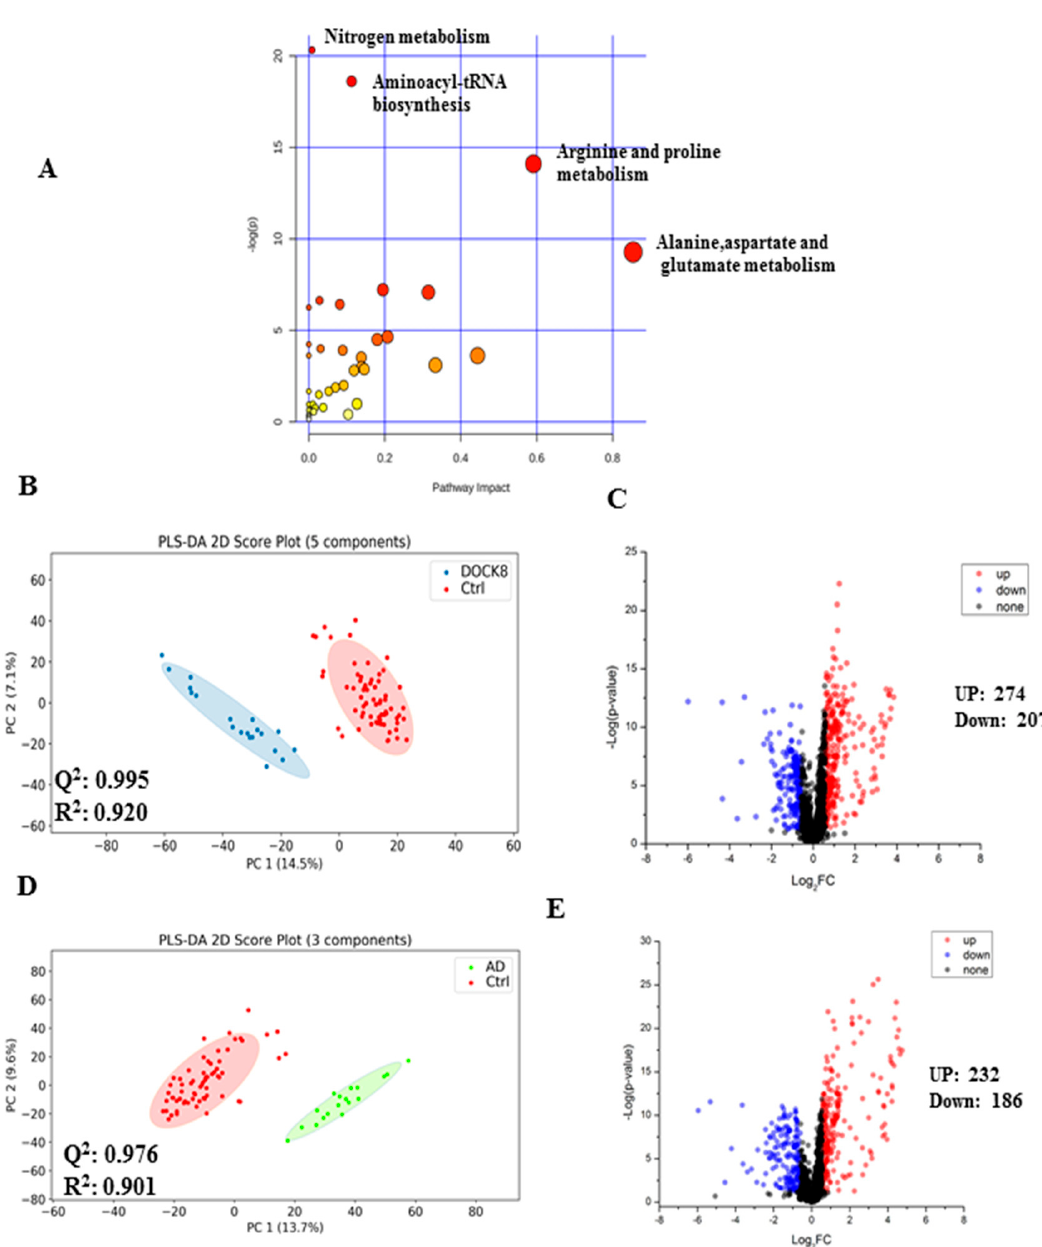
Figure 2. Pathway analysis and binary comparisons in serum of patients with DOCK8 deficiency and atopic dermatitis. ( A ) Pathway analysis for DOCK8-deficient patients vs. Ctrl comparison. ( B ) DOCK8- deficient ( n = 10 run in duplicates) vs. Control ( n = 33 run in duplicates). PLS-DA score plot with a calculated space R 2 = 0.995 and Q 2 = 0.920. Five latent variables were used because it has the highest cross-validation Q 2 value. ( C ) Volcano plots (DOCK8 deficient patients vs. control) with fold change > 1.5 (up-regulated = 274 metabolites) and < 0.67 (down-regulated = 207 metabolites); q = 0.049, p = 0.107, 40 metabolites were positively identified. ( D ) Atopic dermatitis (AD) ( n = 9) vs. Control ( n = 33). PLS-DA score plot, with a calculated space R 2 = 0.976 and Q 2 = 0.901, three latent variables were used because it has the highest cross-validation Q 2 value. ( E ) Volcano plot with fold change > 1.5 (up-regulated = 232) and < 0.67 (down-regulated = 186), q = 0.050, p = 0.055, a total of 37 metabolites were positively identified. Abbreviations: DOCK8, dedicator of cytokinesis 8; AD, atopic dermatitis; PLS-DA, partial least square discrimination analysis; PC, principal component. In this group, only 37 metabolites were positively identified using the dansyl standard library (Table S3). Seven metabolites were positively identified using the dansyl standard library after a binary comparison between DOCK8-deficient and AD cohorts (Figure 3A, B), while a total of 147 metabolites were dysregulated (118 and 29 metabolites were up and down-regulated in DOCK8